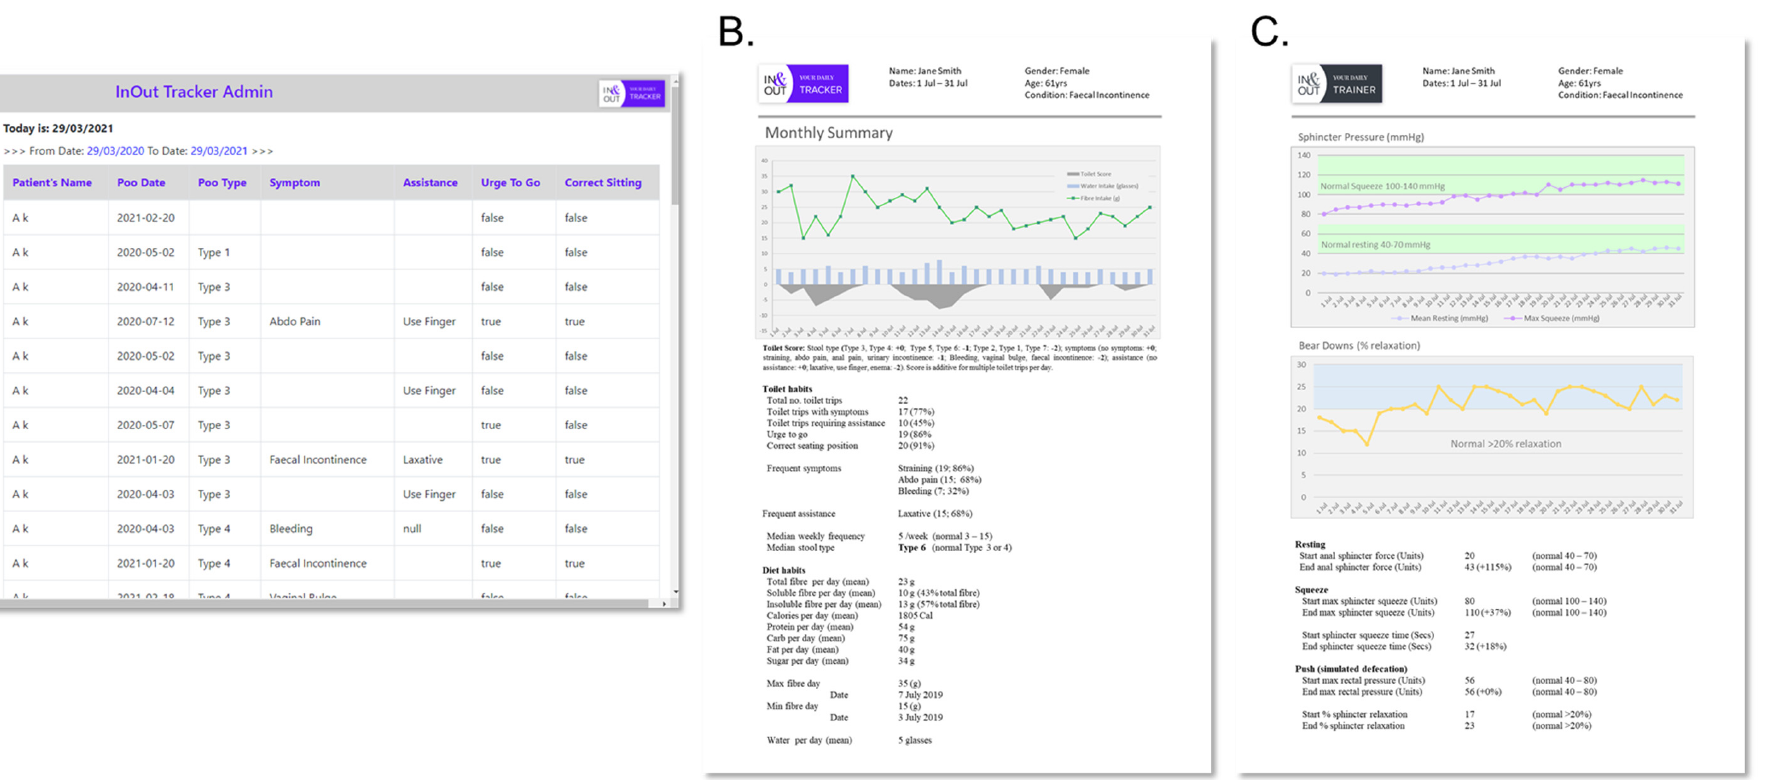
Figure 7. ( A ) Web application for user data search. ( B ) Example of summary report for bowel digital diary. ( C ) Example of summary report for biofeedback training.